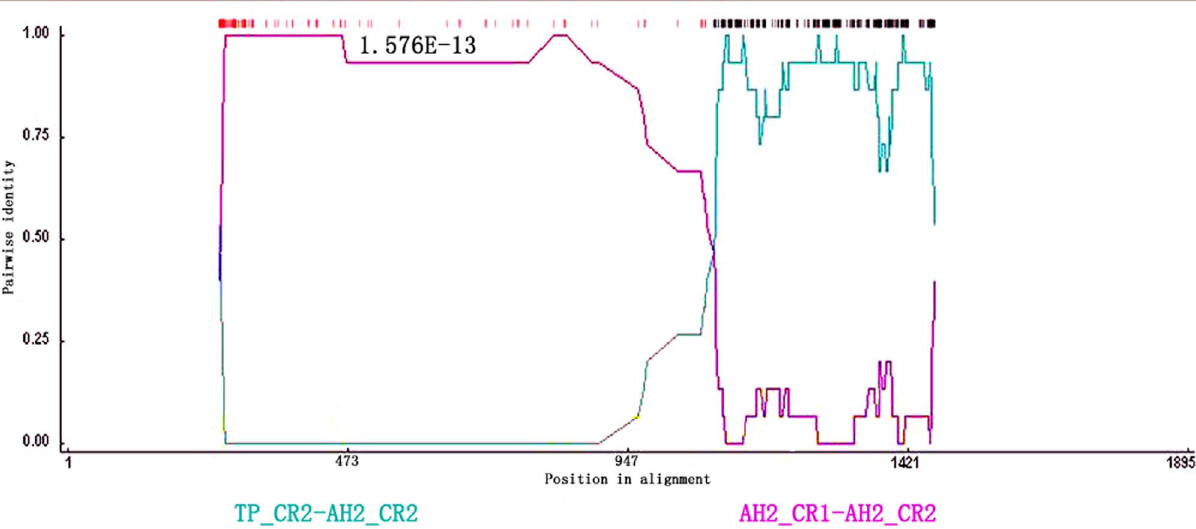
Figure 6. Assessment of recombination in duplicate CRs detected by RDP software in an individual, AH2. Green shade indicates pairwise identity between orthologous CR2 genes in individuals, TP and AH2. Purple shade depicts pairwise identity between paralogous CRs from AH2. Similar analysis was performed for all individuals.